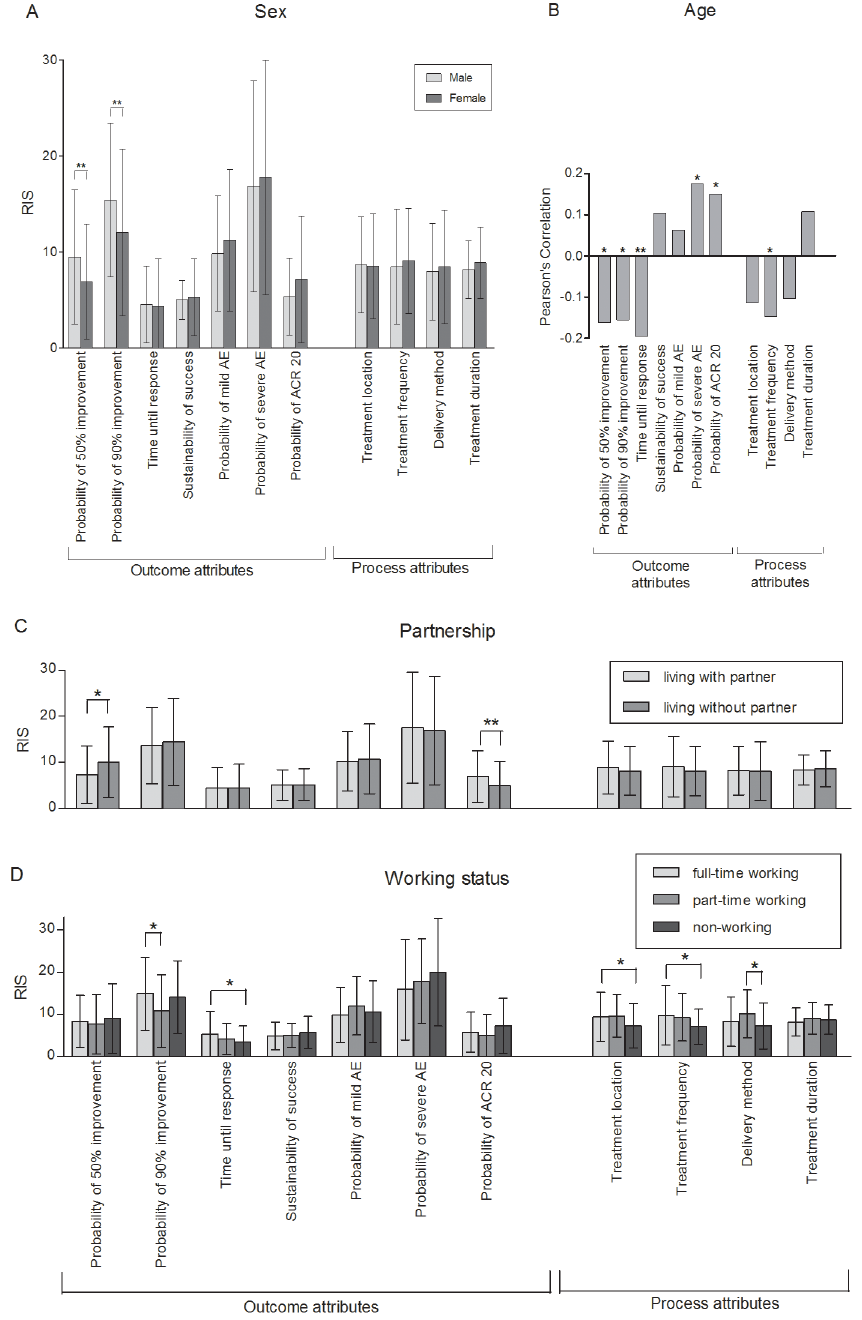
Fig 2. Impact of gender, age, partnership and working status on patients ’ preferences. (A) Men attached higher value to the probability of 50% and 90% improvement than women. (B) Probability of 50% and 90% improvement, time until response and treatment frequency became less important with increasing age whereas probability of severe AE and probability of ACR 20 response gained relevance. (C) Participants without a partner placed greater importance on the probability of 50% improvement while respondents with a partner valued the probability of ACR 20 response higher. (D) Compared to non-working participants, full- time working participants set higher priority to time until response, treatment location, and treatment frequency. The probability of 90% improvement was more important for full-time working than for part-time working participants. Part-time working participants considered the delivery method more important than non- working participants. Differences in RIS were tested for significance with ANOVA (A, C), 2-tailed t-test (B) or Bonferroni post-hoc tests (D). Bars: Means with standard deviations (A, C, D) or Pearson ’ s Correlations (B). RIS: Relative Importance Scores. * p (cid:3) 0.05, ** p (cid:3) 0.01.